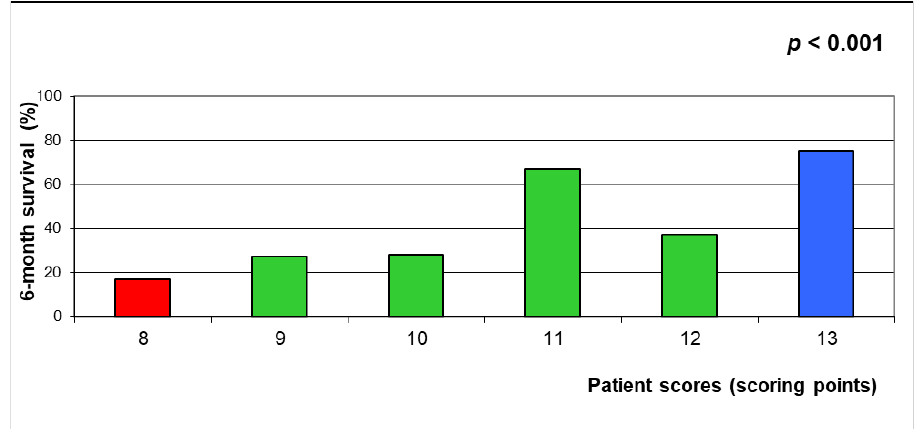
Figure 3. Model 2 (including KPS, number of lesions, and age): Six-month survival rates of patient scores ranging between 8 and 13 points.